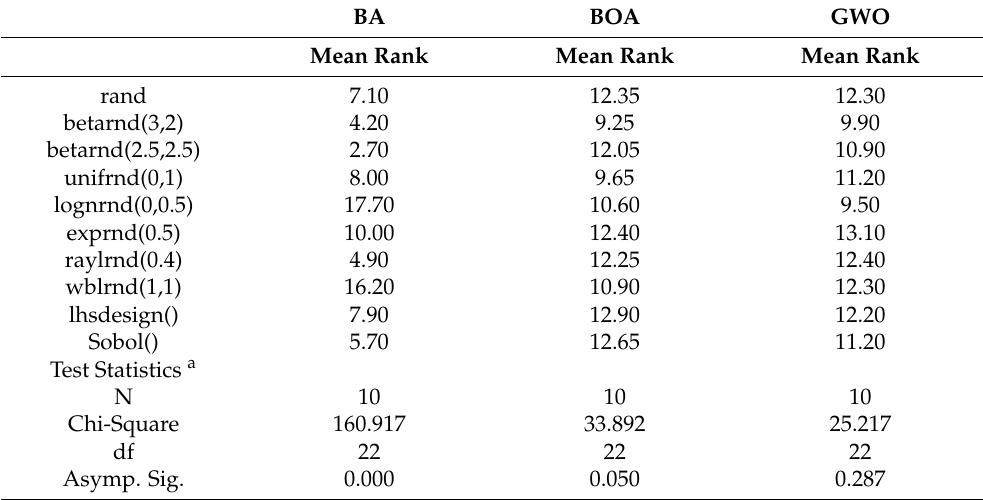
Table 20. Friedman’s test for classical